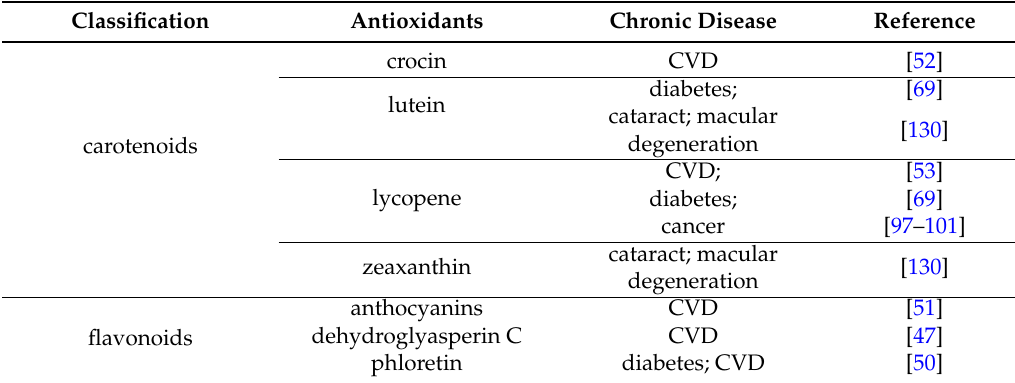
Table 1. Antioxidant phytochemicals and their target chronic